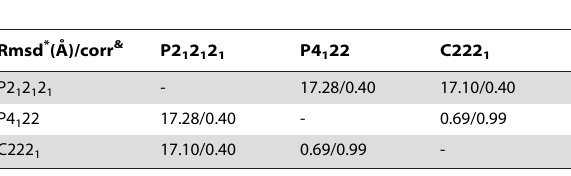
Table 1. Statistics of inter-dimer distance between 2 neighboring dimers in the 3 space groups.